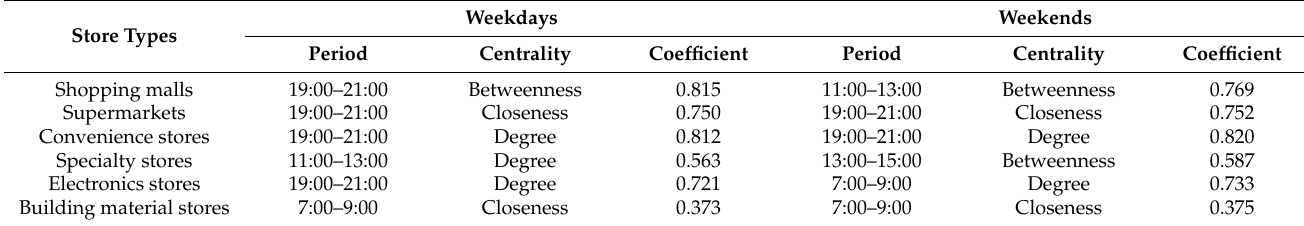
Table 6. Highest correlation coefficients of all